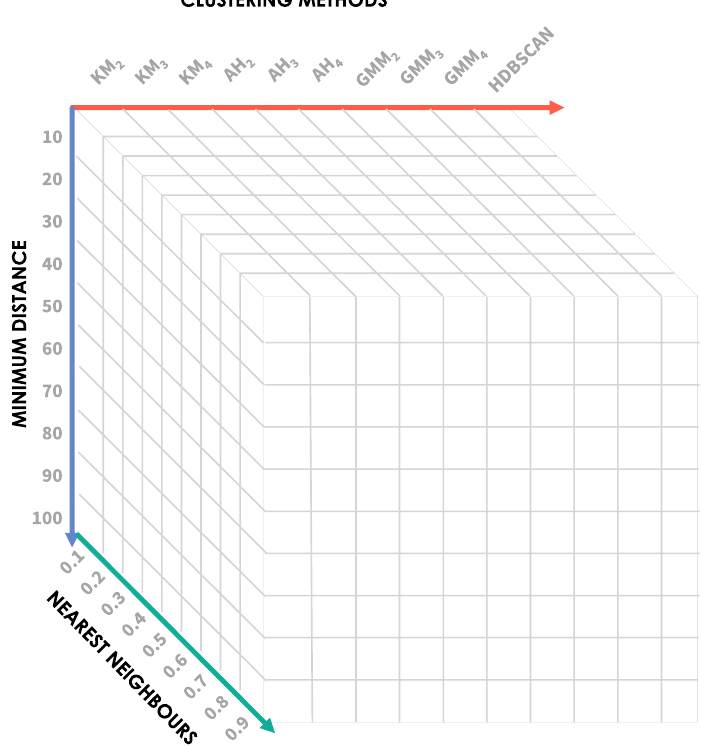
Figure 2. Representation of the number of clustering solutions obtained for each seizure and feature group. Four clustering methods were applied to UMAP-reduced three-dimensional datasets (KM: K-means clustering for k = 2, 3, 4 , AH: agglomerative hierarchical clustering for k = 2, 3, 4 , GMM: Gaussian mixture models for k = 2, 3, 4 and HDBSCAN). Parameter tuning was performed for UMAP (ten values of nearest neighbours and nine values of minimum distance). The final reduced data obtained before each seizure’s onset and for each feature reduction method corresponds to the maximum DI obtained among the computed clustering